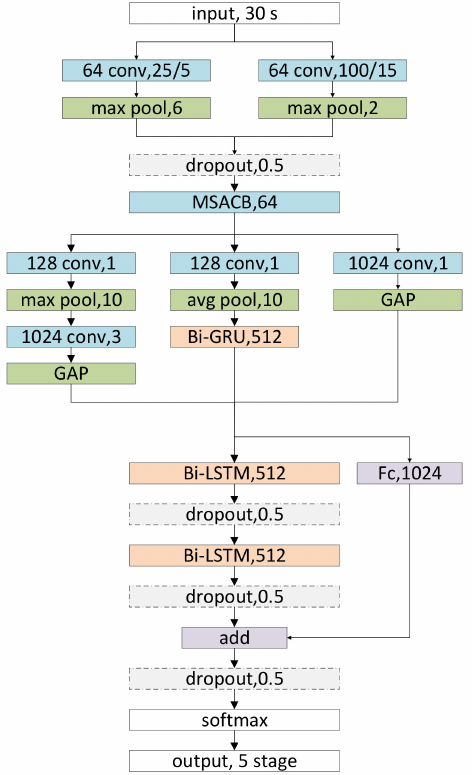
Figure 2. Overall architecture of CCRRSleepNet network. Conv is convolution, MSACB is multiscale atrous convolution block, GAP is global average pooling, Bi-GRU is two-way GRU network,